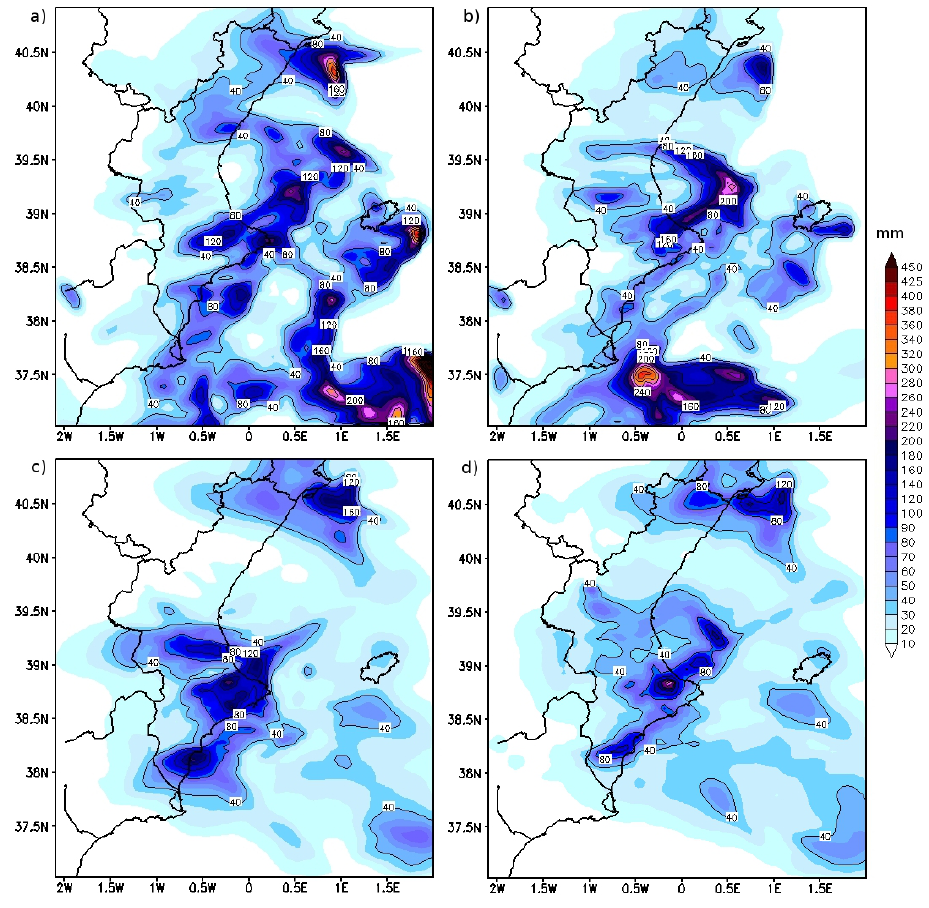
Fig. 11. RAMS grid 3 48-h accumulated resolved precipitation for Kuo experiments : (a) Kuo1, (b) Kuo2, (c) Kuo3 and (d)